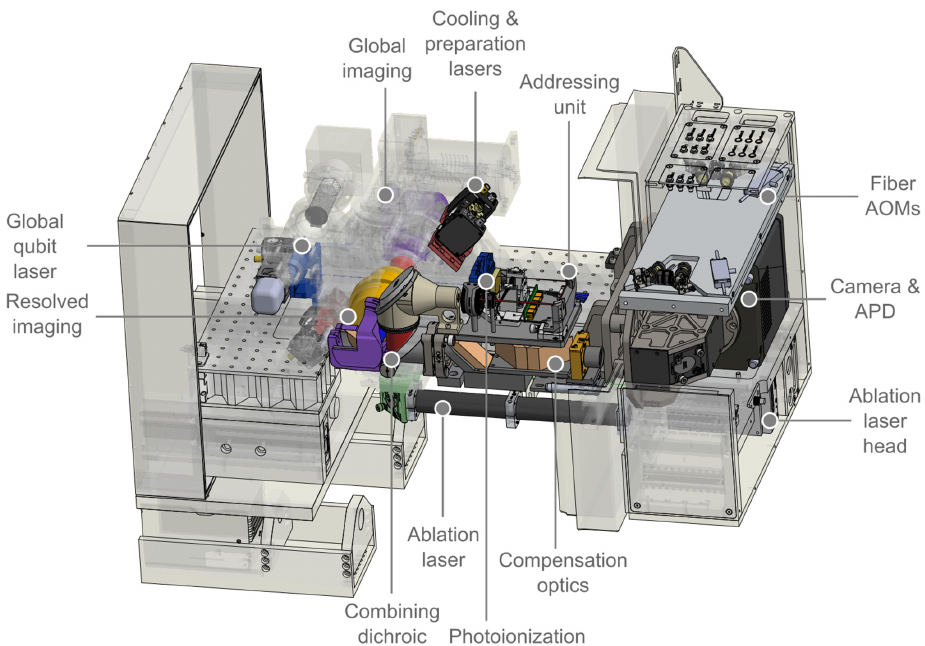
FIG. 7. Schematic of the trap drawer detail, focusing on optical and detection components, displayed with extended (opened) drawer. Optical interfacing with the ions is achieved via fiber delivery for Doppler cooling, polarization gradient cooling, quenching and repumping (red pair), as well as the collective qubit laser (blue, left) and photoionization (blue, right). Free-space delivery of the pulsed ablation laser is achieved via access from below (green). Single-site addressing lasers are steered by an addressing unit, and overlapped with the resolved detection path (high-NA objective, yellow) on a dichroic beam combiner (silver). Compensation optics for resolved light counter abberations introduced via the combiner. Collective imaging to an APD leaves at the back of the chamber (purple). Detection electronics and light sources are situated outside the μ -metal shielding. Fiber AOMs allow pulsing and imprinting of bichromatic sidebands onto the qubit